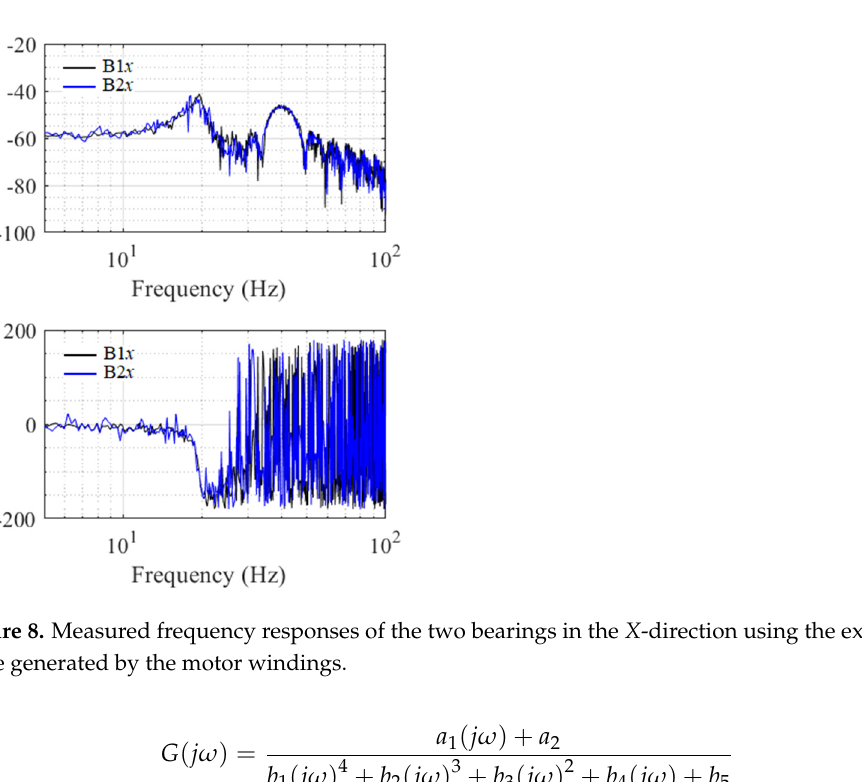
Figure 7. Measured frequency responses of the BELM rotor and Bearing 1 in the X -direction using excitation forces generated by the motor windings and the suspension windings. ( a ) Measured frequency responses of the BELM rotor and Bearing 1 in Experiment 1; ( b ) Measured frequency responses of the BELM rotor and Bearing 1 in Experiment 2.